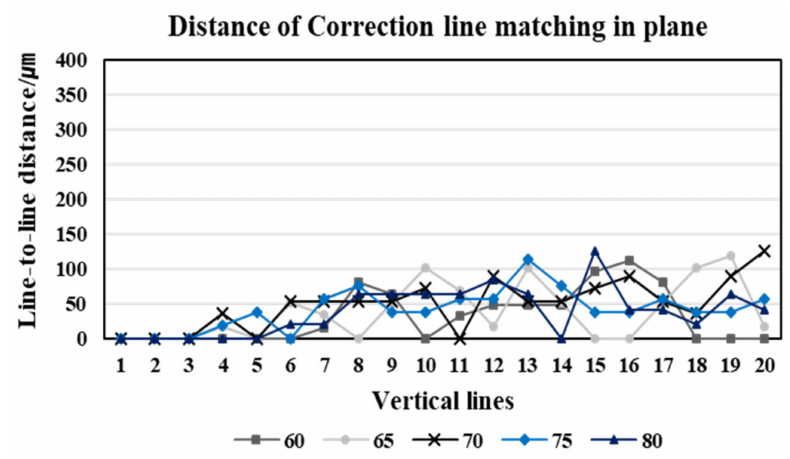
Figure 7. The stereo matching results of the corrected stereo images in the plane.